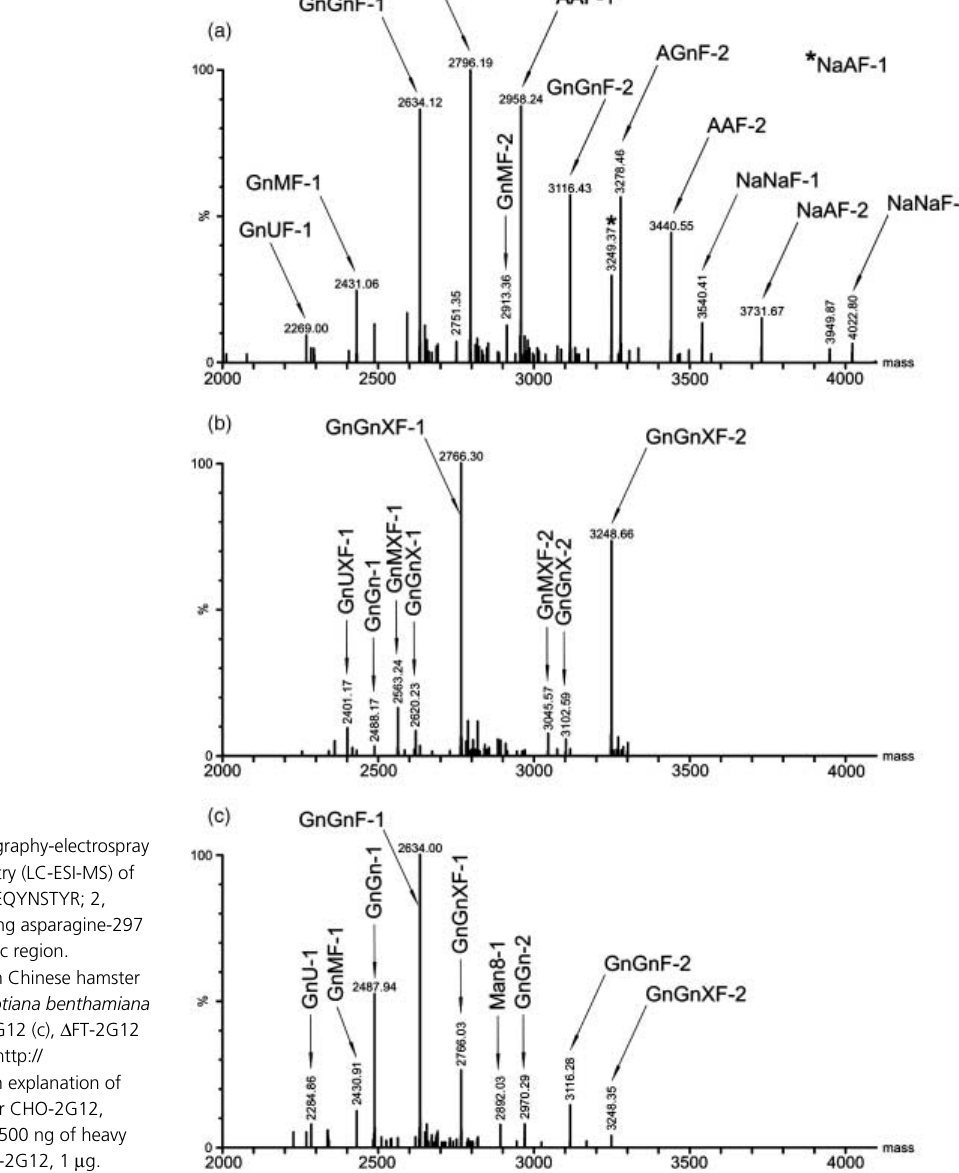
Figure 4 Liquid chromatography-electrospray ionization-mass spectrometry (LC-ESI-MS) of glycosylated peptides (1, EEQYNSTYR; 2, TKPREEQYNSTYR) containing asparagine-297 (Asn-297) from the 2G12 Fc region. Glycopeptides derived from Chinese